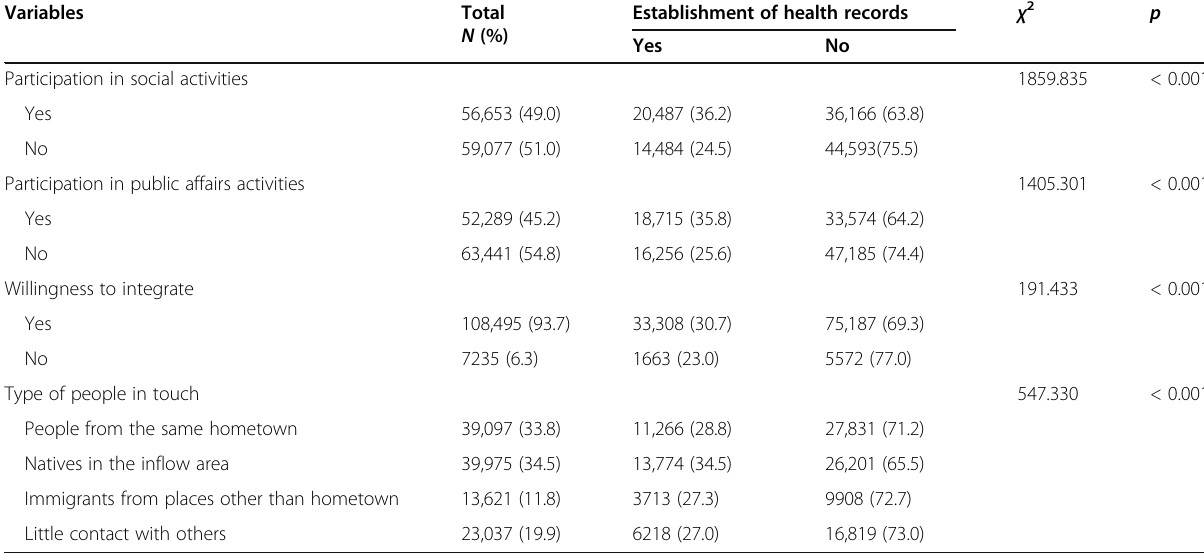
Table 4 Social integration characteristics and the establishment of health records ( N = 115,730) Variables